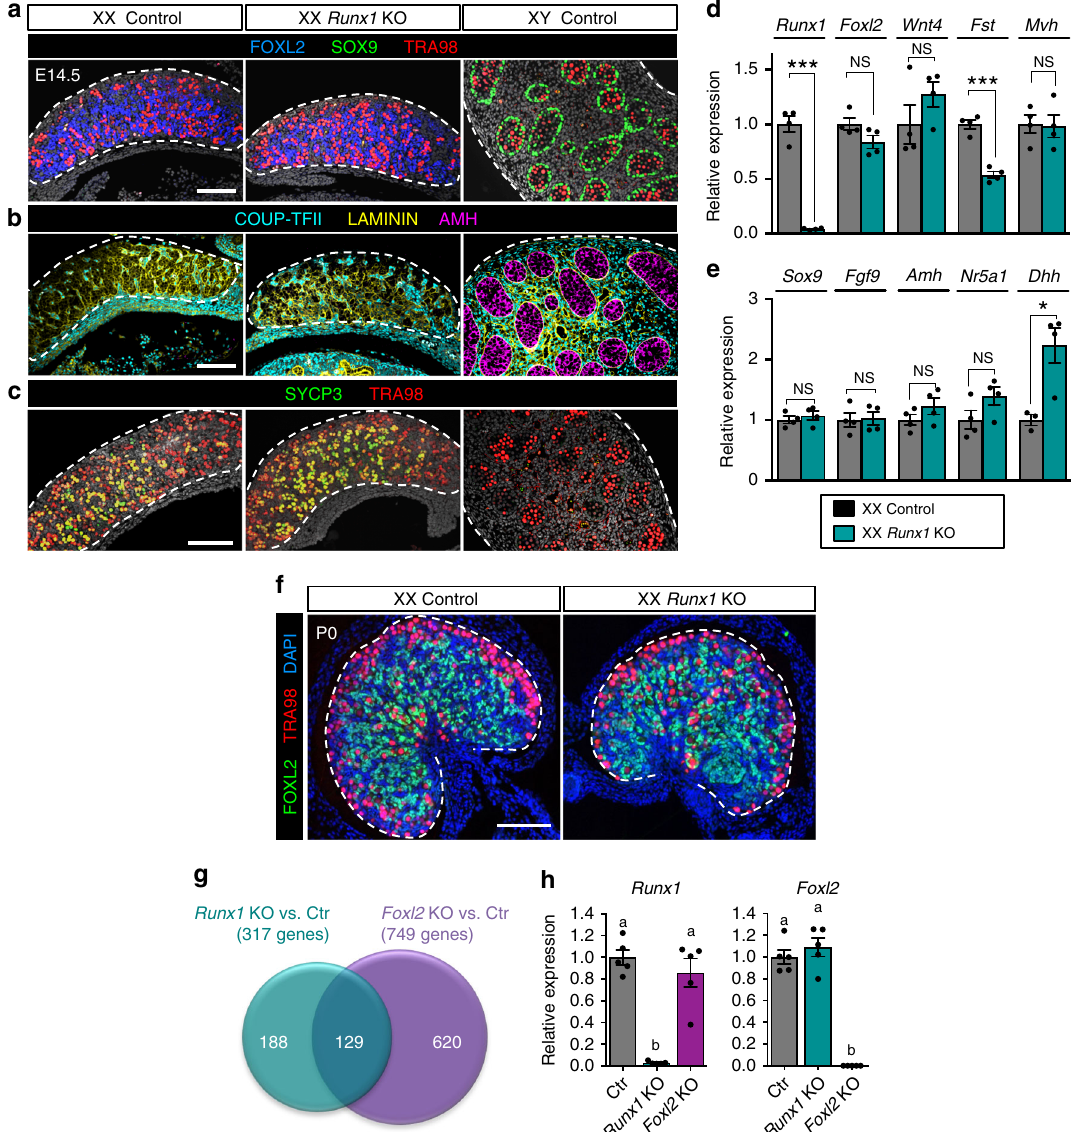
Fig. 4 Inactivation of Runx1 in the ovarian somatic cells has minimal impacts on morphogenesis of the ovary with the exception of transcriptomes. Immuno fl uorescences for a pre-granulosa cell marker FOXL2, Sertoli cell marker SOX9, and germ-cell marker TRA98; b interstitial cell marker COUP-TFII (encoded by Nr2f2 gene), Laminin, and Sertoli cell marker AMH; c meiotic cell marker SYCP3 and germ-cell marker TRA98 in E14.5 XX control, XX Runx1 KO, and XY control gonads. The gray color represents DAPI nuclear staining. Single-channel images are provided in Supplementary Fig. 2. Expression of d pre-granulosa or germ-cell-speci fi c genes and e Sertoli or Leydig cell-speci fi c genes in XX control and XX Runx1 KO gonads at E14.5 by quantitative PCR ( n = 5). Values are presented as mean ± SEM.; unpaired Student ’ s t -test; * p < 0.05, *** p < 0.001; NS, not signi fi cant. f Immuno fl uorescence for FOXL2, TRA98, and nuclear counterstain DAPI (blue) in XX control and Runx1 KO gonads at birth (P0). Scale bar: 100 µ m. g Venn diagram comparing the 317 genes differentially expressed in XX Runx1 KO vs. XX Control gonads with the 749 genes differentially expressed in XX Foxl2 KO vs. XX Control gonads at birth. Forty-one percent of the genes differentially expressed in Runx1 KO (129/317) were also misregulated in the absence of Foxl2 . Genes differentially expressed were identi fi ed by microarray ( n = 4/genotype; fold change > 1.5, one-way ANOVA p < 0.05). h Quantitative PCR analysis of Runx1 and Foxl2 mRNA expression in XX control, Runx1 KO, and Foxl2 KO gonads at birth ( n = 5/genotype). Values are presented as mean ± SEM. One-way ANOVA, p < 0.05. Bars with different letters ( a , b ) are signi fi cantly different. For all experiments, controls are wild-type littermates of Runx1 KO mice. Source data are provided as a Source Data fi le. For the immuno fl uorescences, at least three independent biological replicates were analyzed and the images presented are representative of all between RUNX1 and FOXL2 to control pre-granulosa cell iden- by chromatin immunoprecipitation (ChIP) followed by whole- tity. The fact that RUNX1 and FOXL2 are both transcription genome sequencing 42 at E14.5, a time where FOXL2 and RUNX1 expression fully overlaps (Fig. 3). We performed additional de factors expressed in the pre-granulosa cells (Fig. 3 and Supple- novo motif analyses on the genomic regions bound by FOXL2 in mentary Fig. 1) raised the question whether this interplay could the fetal ovary, and discovered that several other DNA motifs occur directly at the chromatin level. We have previously iden- were co-enriched with FOXL2 DNA motif (Fig. 8a). RUNX DNA ti fi ed FOXL2 chromatin occupancy during ovarian differentiation